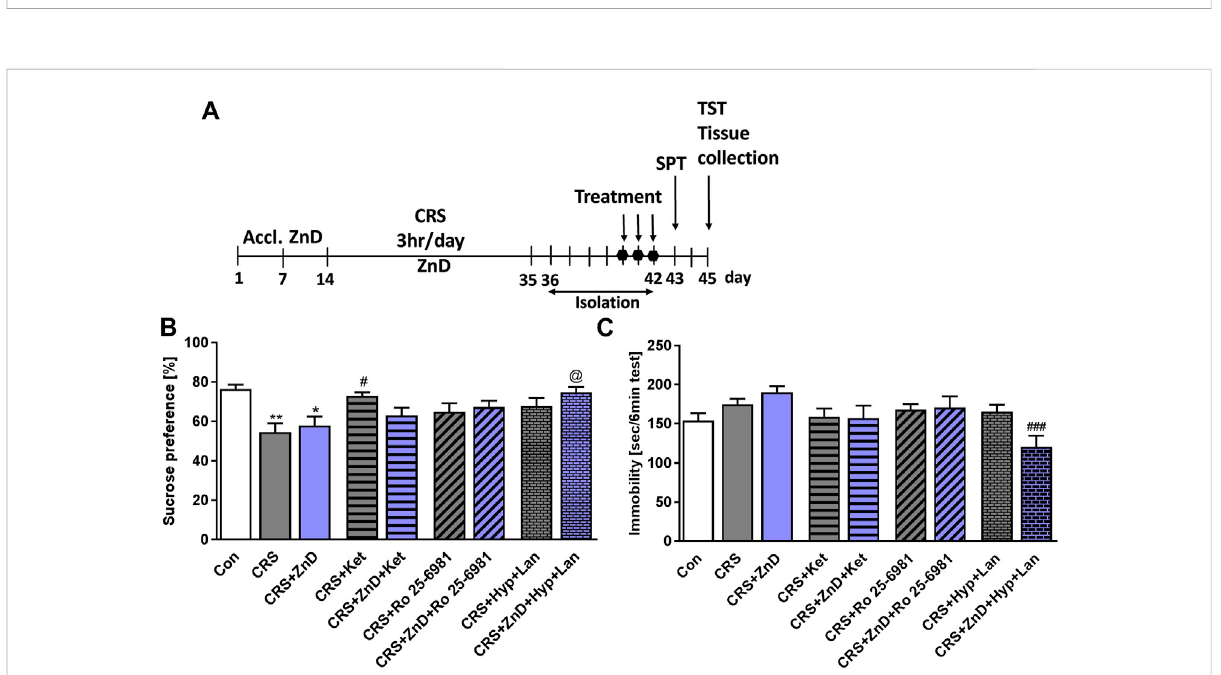
FIGURE 3 Effects of Zn-de fi cient diet and CRS on the antidepressant-like activities of three doses of atypical antidepressant compounds (ketamine: 10 mg/kg, Ro 25 – 6981: 10 mg/kg, Hyp: 2.5 mg/kg + Lan: 10 mg/kg) in the SPT and TST in mice. (A) Experimental schedule of drug treatments and behavioral tests. (B) SPT was performed 24 h after thelast treatment. (C) TST was performed 72 h after the last treatment. All valuesare expressedas mean ± SEM. The data were analyzed by one-way ANOVA and Newman – Keuls multiple comparison test. (B) F(8, 92) = 3,948; p < 0.0005; * p < 0.05;** p < 0.01vs.Con,# p < 0.05vs.CRS, @ p < 0.05vs.CRS+ZnD,n=9 – 12; (C) F(8,98)=3,247; p =0.0025; ### p < 0.001vs.CRS+ZnD,n=10 – 13. Con: control, ZnD: zinc de fi cient diet, CRS: chronic restraint stress, Hyp: hyperforin, Lan: lanicemine, SPT: sucrose preference test, TST: tail suspension